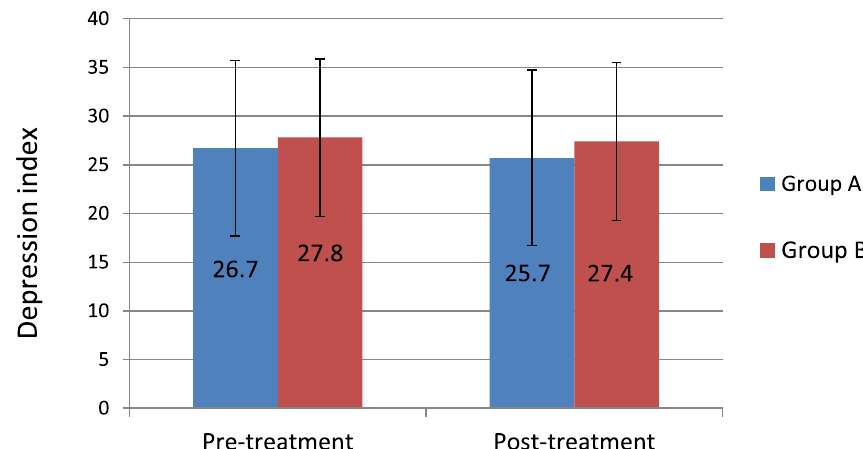
Fig. 4 The mean values of depression index pre- and post-treatment between both groups